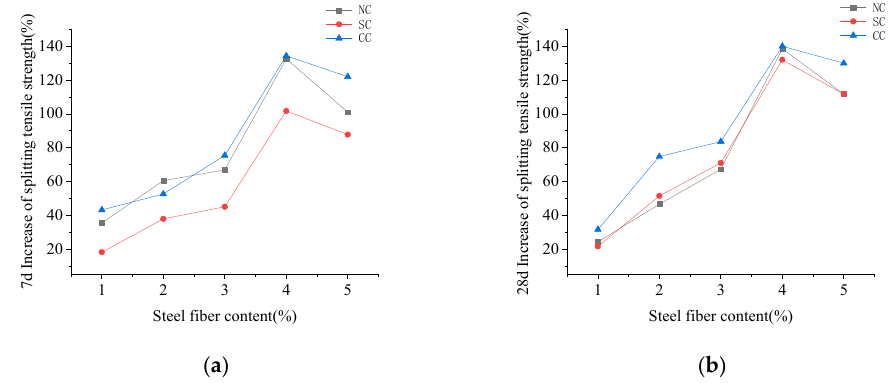
Figure 12 . Splitting tensile strength of steel fiber RPC with different dosages: ( a ) 7-day splitting tensile Figure 12. Splitting tensile strength of steel fiber RPC with di ff erent dosages: ( a ) 7-day splitting tensile strength; ( b ) 28-day splitting tensile strength. strength; ( b ) 28-day splitting tensile strength.